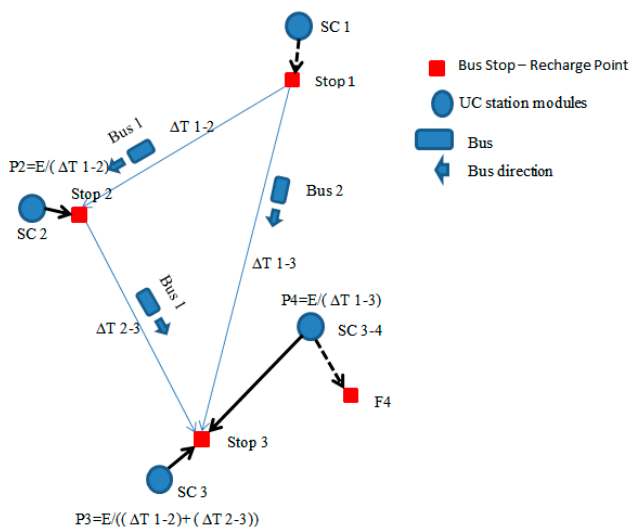
Figure 11. Proposed criteria for network management.